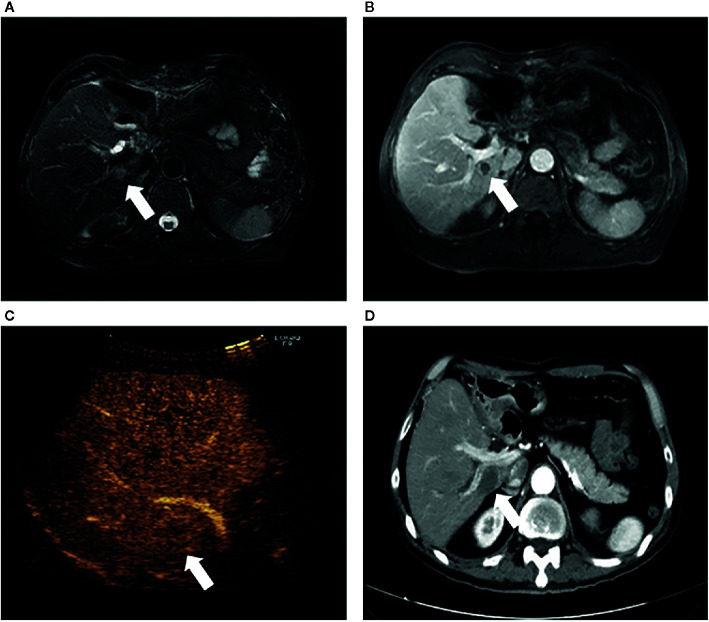
Images in a 61-year-old-man who underwent radiofrequency ablation (RFA) for periportal CLM. (A) Axial MRI T2-weighted images shows a 2.2-cm lesion of high signal intensity (arrow) in segment VII before RFA. (B) Axial enhanced MRI image shows that the lesion (arrow) washes out in equilibrium phase; (C) contrast-enhanced ultrasonography (CEUS) image before RFA shows that the index tumor (arrow) is in contact with the portal vein. The patient underwent RFA, and obtained technical effectiveness 1 month after RFA. (D) Axial enhanced CT image shows no local tumor progression around the ablation zone 17 months after RFA. CLM, colorectal liver metastases; US, ultrasound; RFA, radiofrequency ablation.